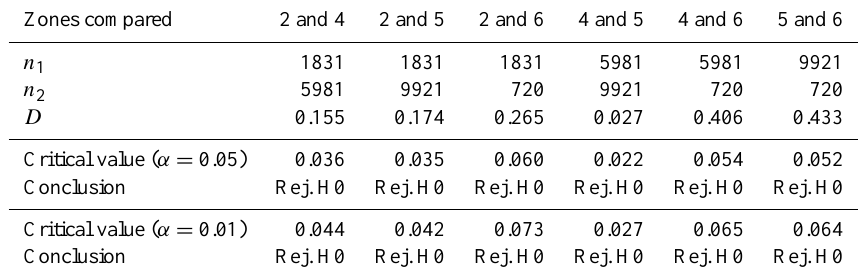
Table 10. Summary of results obtained in the Kolmogorov–Smirnov test for time.